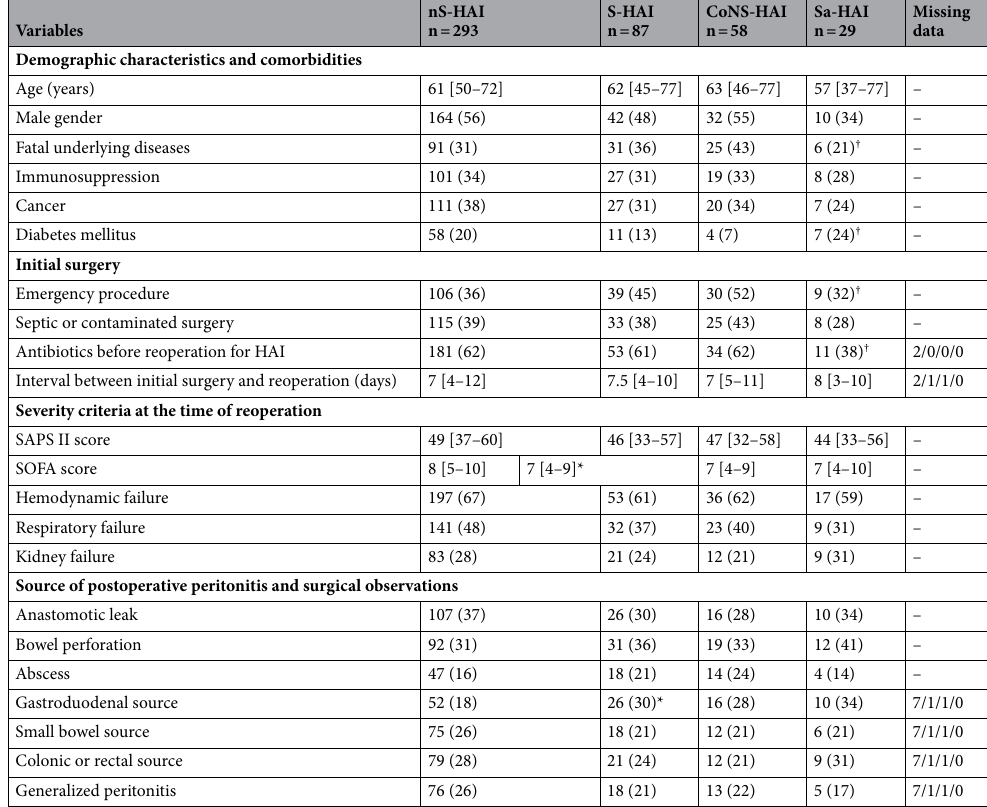
Table 1. Clinical characteristics of the study population. HAI Hospital-acquired postoperative intra- abdominal infection, nS-HAI infection without peritoneal staphylococci culture, S-HAI infection with